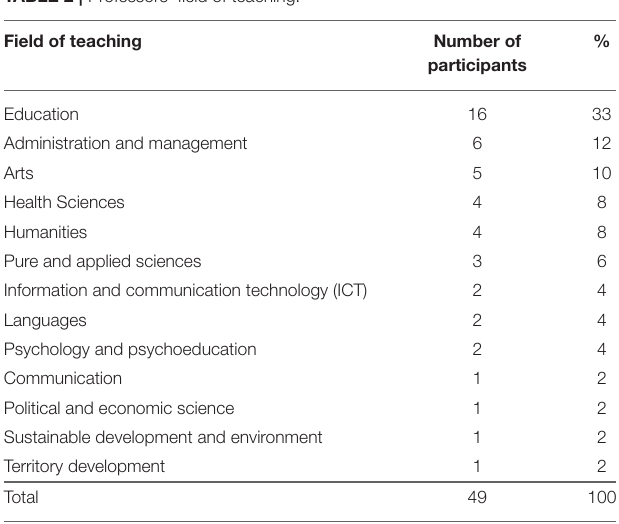
TABLE 2 | Professors’ field of